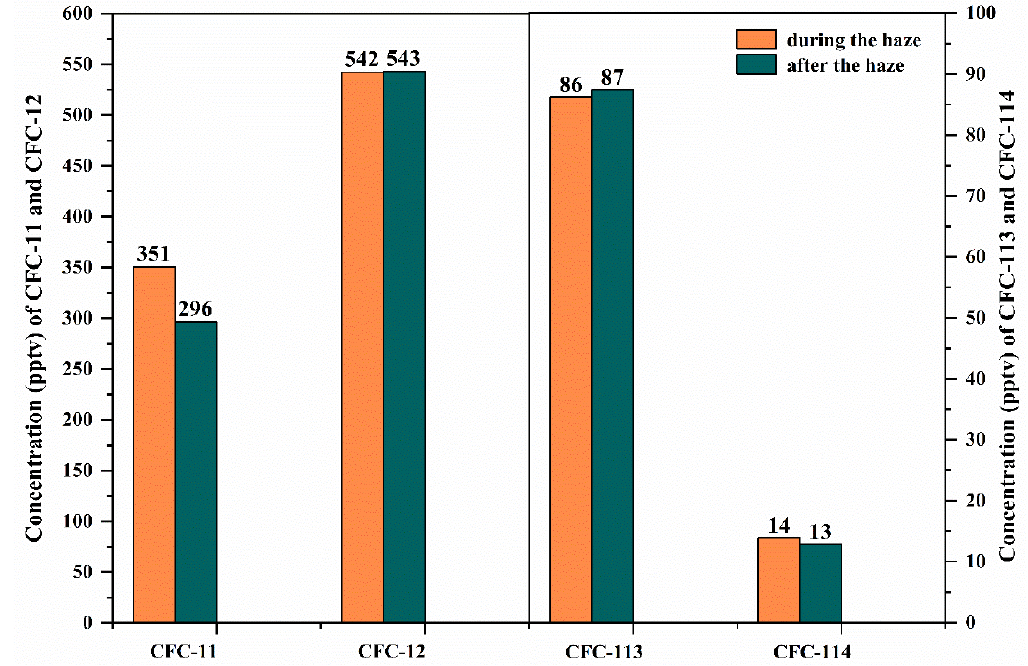
Figure 3. Chlorofluorocarbon (CFC) concentrations during and after haze event in urban Jinan